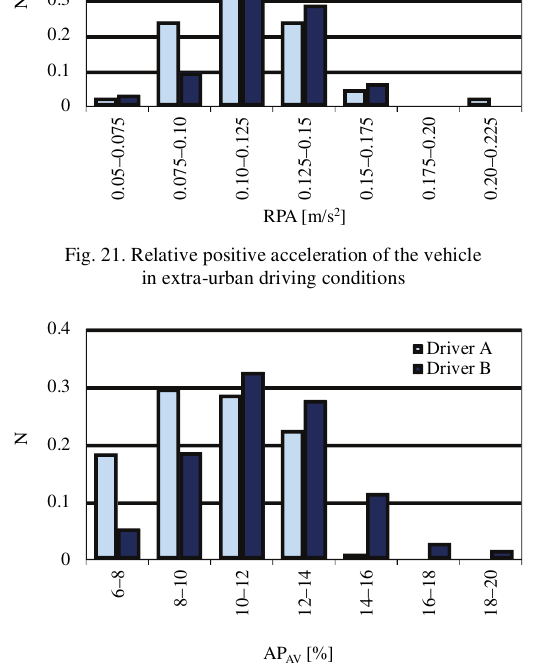
Fig. 18. The average value of the velocity and acceleration product in urban driving conditions